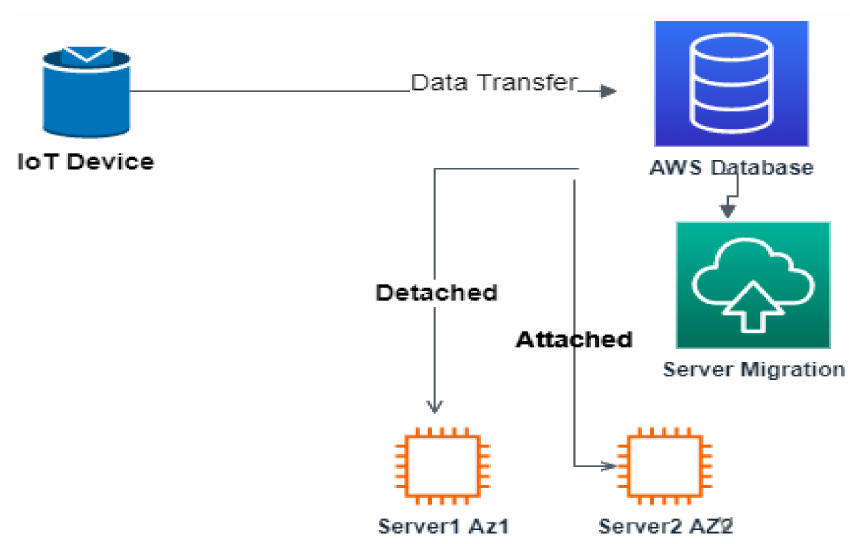
Figure 9. Securing IoT data in the cloud using MTD.